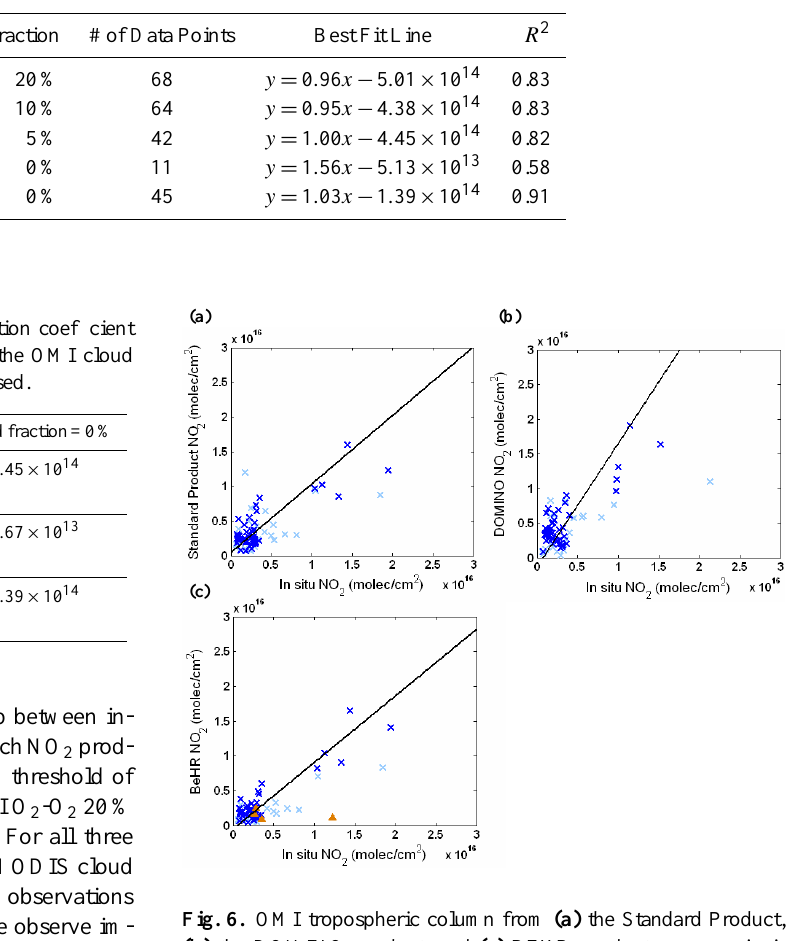
Fig. 6. OMI tropospheric column from (a) the Standard Product, (b) the DOMINO product, and (c) BEHR product versus coinci- dent aircraft-derived column NO 2 . Observations are over land only. All observations correspond to an OMI cloud fraction of less than 20%. Dark blue points show where MODIS cloud fraction is 0%. The black line shows the fit to all data. Fits and correlations are included in Table 3. Orange triangles in (c) show the comparison of the BEHR retrieval and in-situ derived columns determined using the full vertical spiral method in Hains et al.